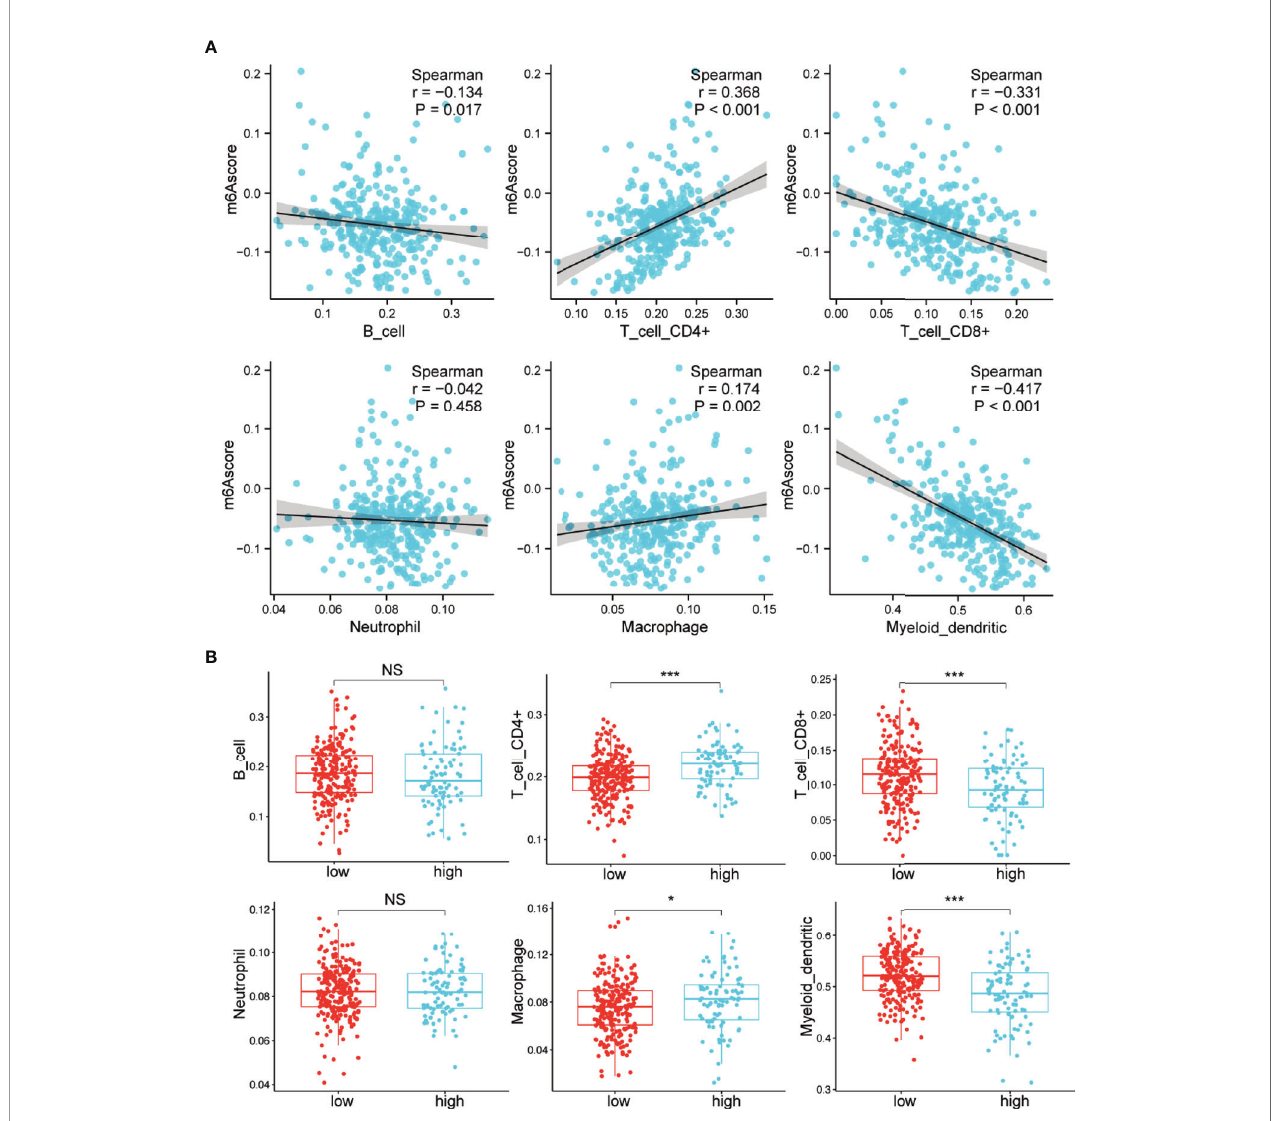
FIGURE 4 | Relationships between the m6A score and in fi ltrating immune cells. (A) Correlations between the m6A score and the degree of immune cell in fi ltration by Spearman analysis. (B) Comparison of the relative abundance of in fi ltrating immune cells between the high and low m6A score groups. NS, not signi fi cant; *p < 0.05; ***p <